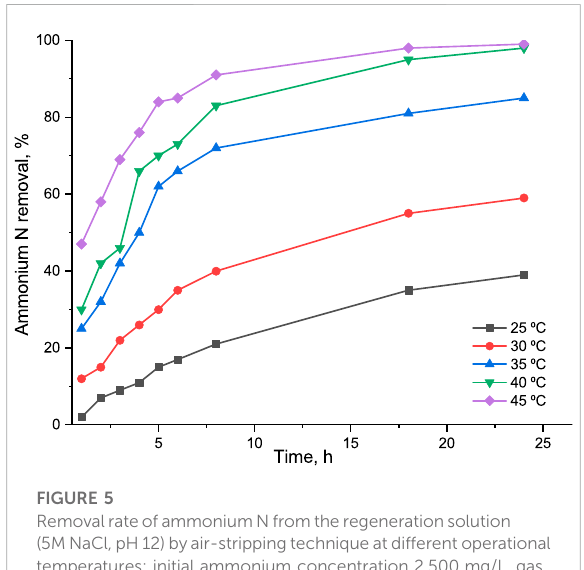
FIGURE 5 RemovalrateofammoniumNfromtheregenerationsolution (5MNaCl,pH12)byair-strippingtechniqueatdifferentoperational temperatures: initial ammonium concentration 2,500 mg/L, gas fl ow 6 L/min, liquid fl ow 0.25